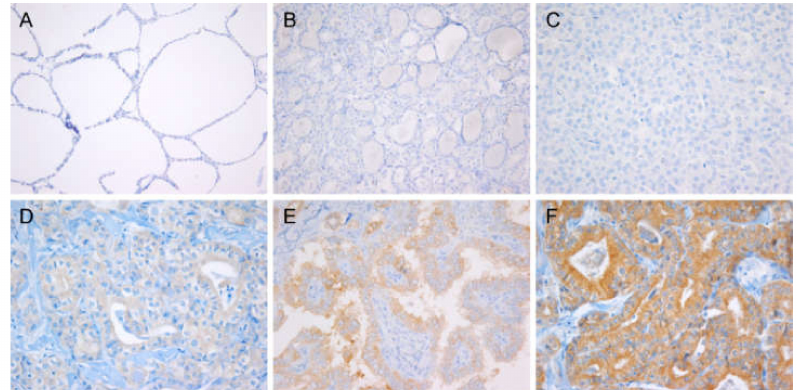
Figure 1. Representative images of BRAF V600E (VE1) immunostaining. Negative staining in normal thyroid tissue ( A , × 200) and NRAS -mutant thyroid tumors ( B , noninvasive follicular thyroid neoplasm with papillary-like nuclear features, × 200; C , follicular thyroid carcinoma, × 200). Papillary thyroid carcinoma (PTC) with BRAF V600E showed variable staining ranged as weak ( D ), moderate ( E ), and strong ( F ) intensity detected in the cytoplasm of tumor cells; × 400.